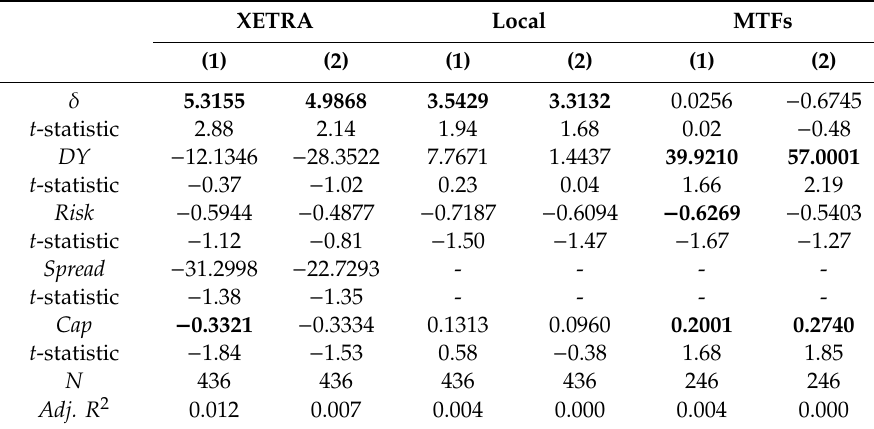
Table 7. Regression of CAV on control